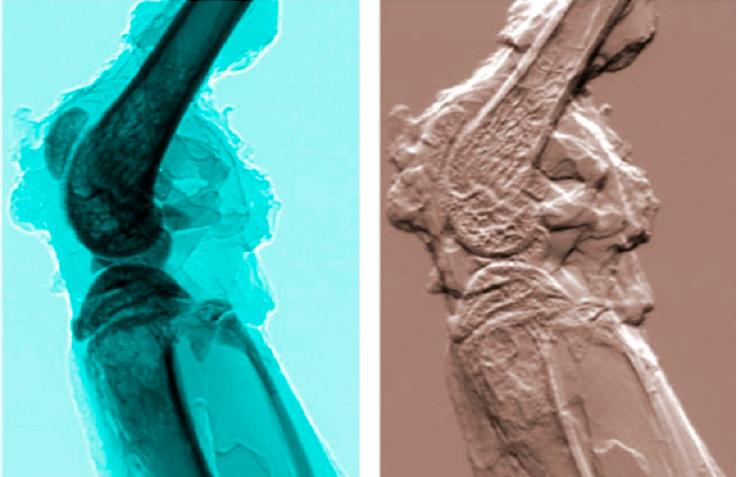
Figure 26. Example of DEI (diffraction-enhanced imaging) [40]: a mouse leg imaged with absorption radiography (left) and with DEI (refractive index) (see Ref. 41, picture reproduced by permission).